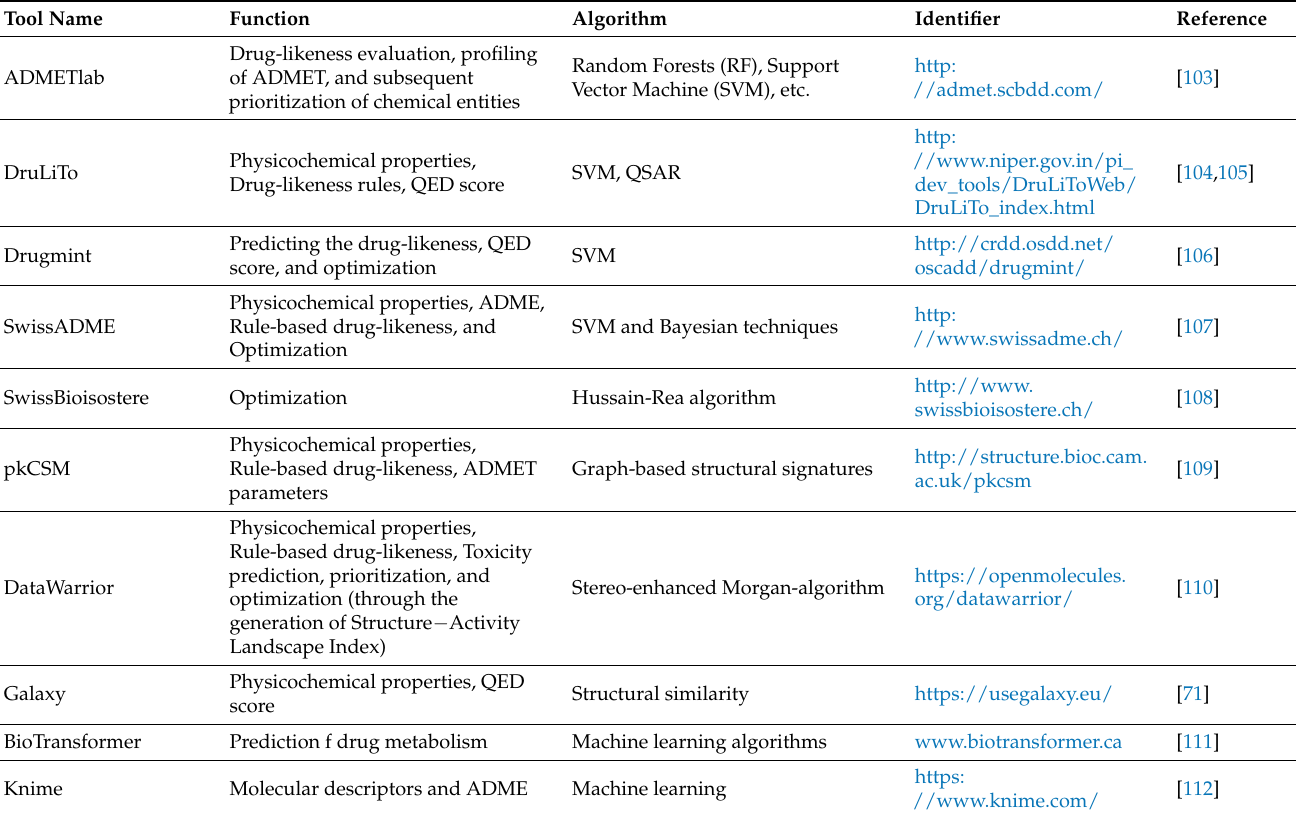
Table 2. Open access in silico tools for cheminformatics characterization, prioritization, and optimization of hits. All the URL were accessed on the 29 May